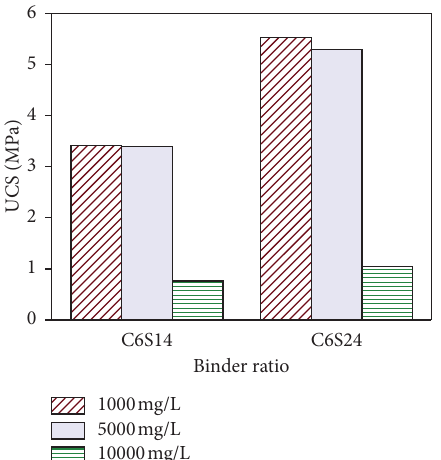
Figure 4: Relationship between the UCS and soda residue content of the stabilized Cr-contaminated